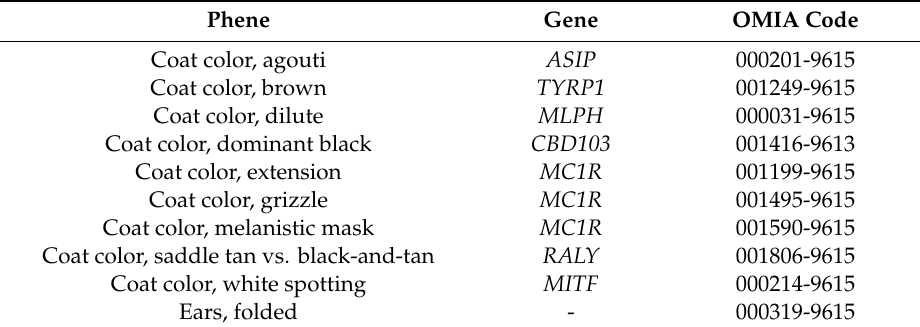
Table 1. Online Mendelian Inheritance in Animals (OMIA)